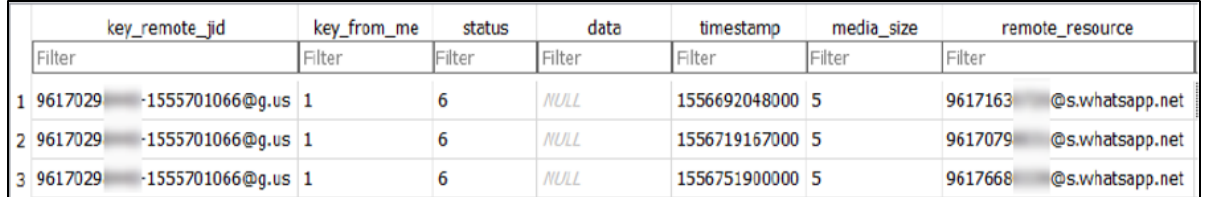
Figure 24. Group’s records created when a member leaves the